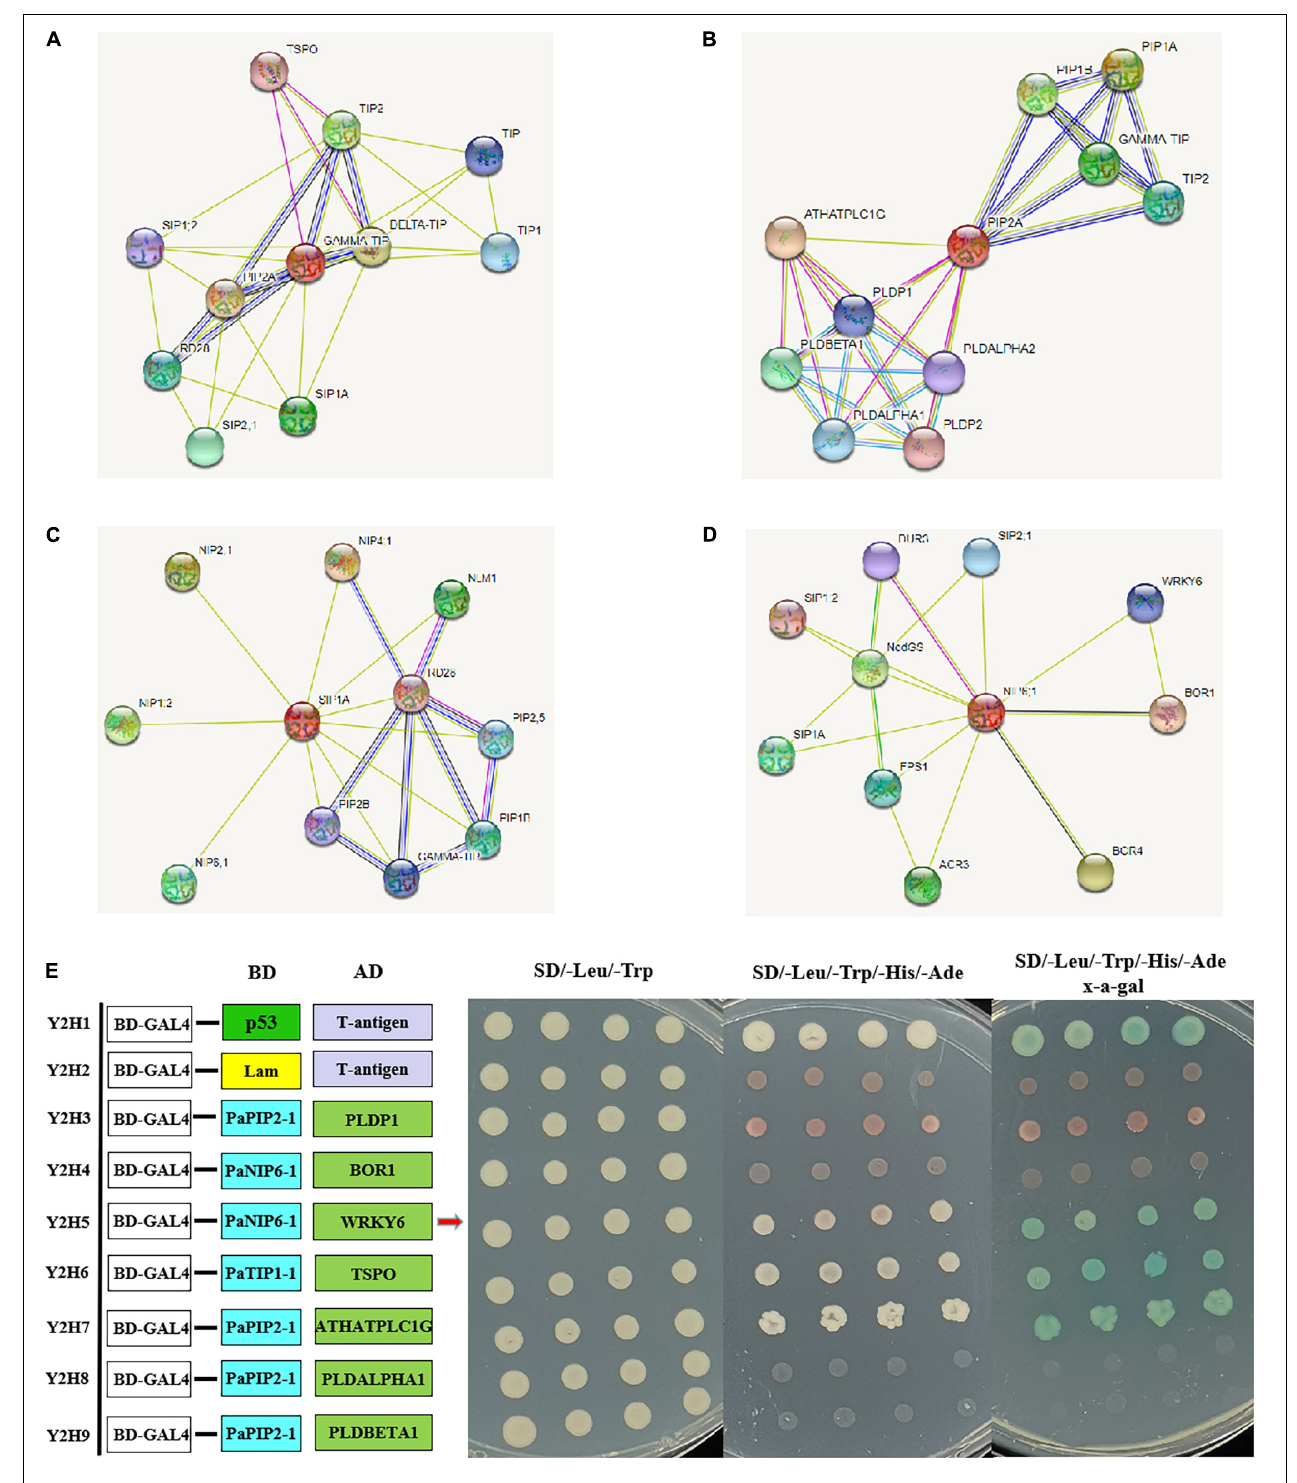
FIGURE 4 | Prediction of the interaction network of PaAQP proteins based on the interactions of their orthologs in A. thaliana . (A) The interaction network of TIP. (B) The interaction network of PIP. (C) The interaction network of SIP. (D) The interaction network of NIP. (E) Y2H assays showing the protein interaction between PaNIP6-1 and WRKY6, PaTIP1-1 and TSPO, and PaPIP2-1 and ATHATPLC1G. The networks were generated from the STRING database. The red circles represent the queried protein, while the other circles are the interacting proteins. The annotation of the predicted interacting protein was derived from UniProtKB (https://www.uniprot.org/). The line thickness indicates the strength of the data support.